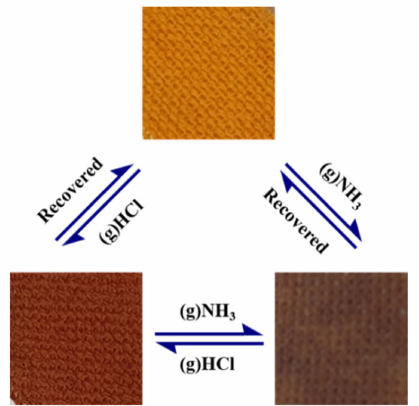
Figure 4. Color of the textile sensor based on mixed dyes before and after exposure to gaseous HCl and NH 3 .